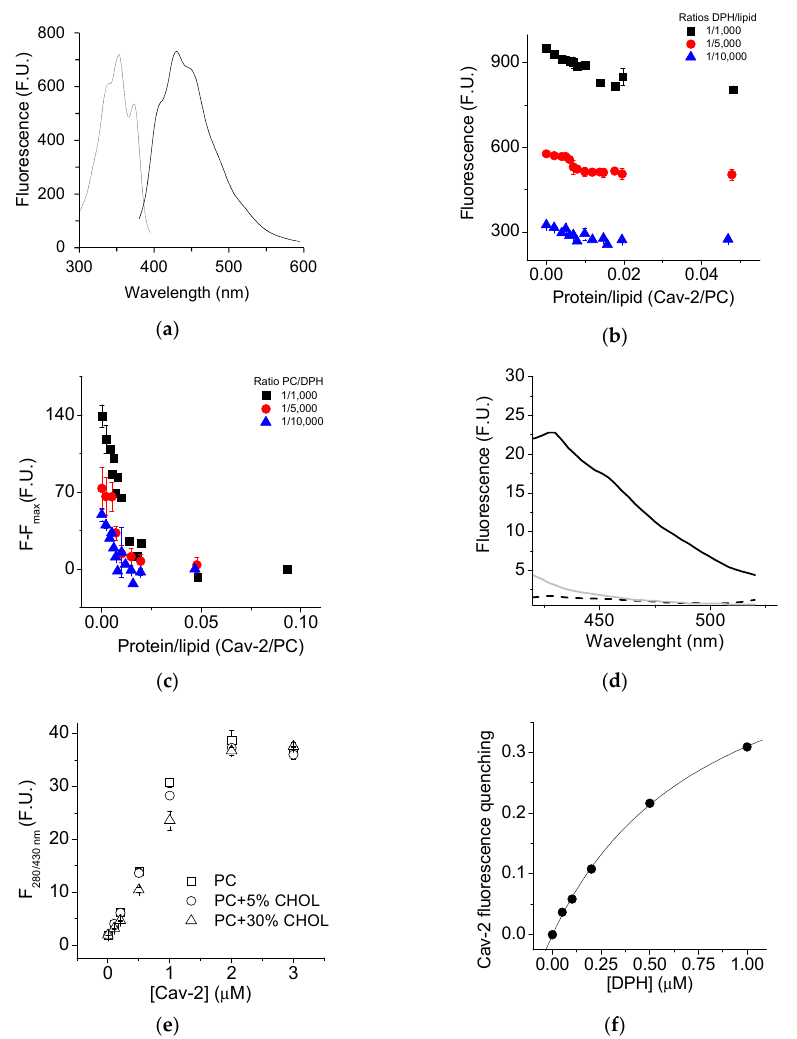
Figure 4. Measurement of Cav-2 interaction with membranes by FRET. Emission (solid line) and excitation (dotted line) spectra were obtained with fixed emission and excitation wavelengths at 452 nm and 354 nm, from SUVs made with egg yolk lecithin 50 µ M of egg yolk lecithin and 0.05 µ M of DPH concentration (panel a ). Fluorescence quenching of DPH dependence upon Cav-2 concentration measured with a constant lipid concentration is shown in (panel b ). DPH was incorporated into PC SUVs at ratios shown in the figure legend keeping constant the PC SUVs concentration at 50 µ M for each experiment. Cav-2 was added to the assay and the ratio Cav-2/lipid was calculated for each point to plot these data in the figure. Data normalization of previous figure by the maximum quenching is shown in (panel c ) by subtracting the maximum quenching exerted by Cav-2 from the initial fluorescence F0 (panel c ). Emission spectra of Cav-2 (3 µ M) (grey line), LUVs (50 µ M) supplemented with DPH (0.05 µ M) (dashed line), and Cav-2 (3 µ M) mixed LUVs (50 µ M) supplemented with DPH (0.05 µ M) (continuous line) were measured with a fixed excitation wavelength of 280 nm with excitation and emission slits of 10 nm each (panel d ). The dependence upon caveolin concentration of the fluorescence recorded with fixed excitation and emission wavelengths of 280 and 430 nm from LUVs (50 µ M) supplemented with different cholesterol concentrations (0%, 5%, and 30%, shown by open squares, open circles, and open triangles, respectively) and 0.05 µ M of DPH is shown in (panel e ). Calculation of the FRET efficiency by measuring at fixed excitation and emission wavelength of 280 nm and 340 nm, respectively, the DPH fluorescence dependence upon caveolin concentration in LUVs (50 µ M) supplemented with DPH (0.05 µ M) measured (panel f